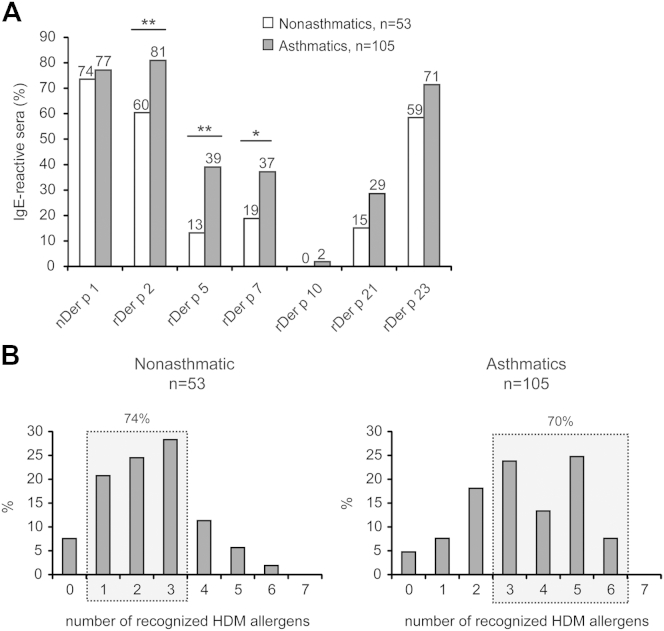
IgE reactivity of asthmatic and nonasthmatic children with HDM allergy to individual HDM allergens. A, IgE binding prevalences (y-axis: percentage) to the allergens as measured with ImmunoCAP ISAC technology for nonasthmatic (white bars) and asthmatic (gray bars) children with HDM allergy. Significant differences between the 2 groups are shown. *P < .05 and **P < .01. B, Number of HDM allergens (x-axes) recognized by nonasthmatic (left panel) or asthmatic (right panel) children with HDM allergy (y-axes: percentages of IgE-reactive patients). Gray boxes denote numbers of allergens recognized by 74% and 70% of the nonasthmatic and asthmatic children, respectively.